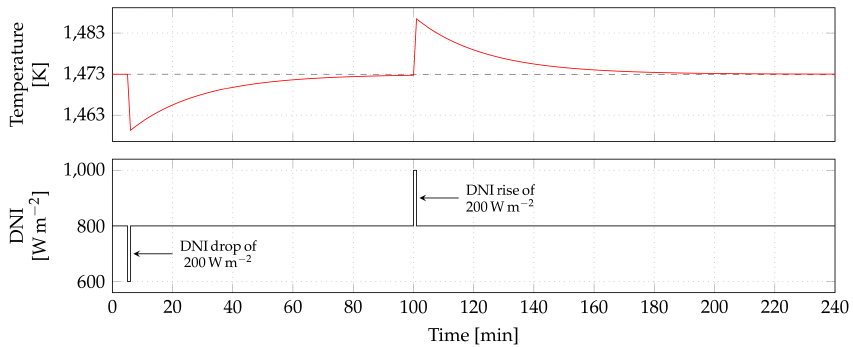
Figure 4. Reactor’s temperature in response to sudden DNI variations with nominal design values = 1.465th − 1 ( T = 1473K, DNI = 800Wm − 2 and f in biomass